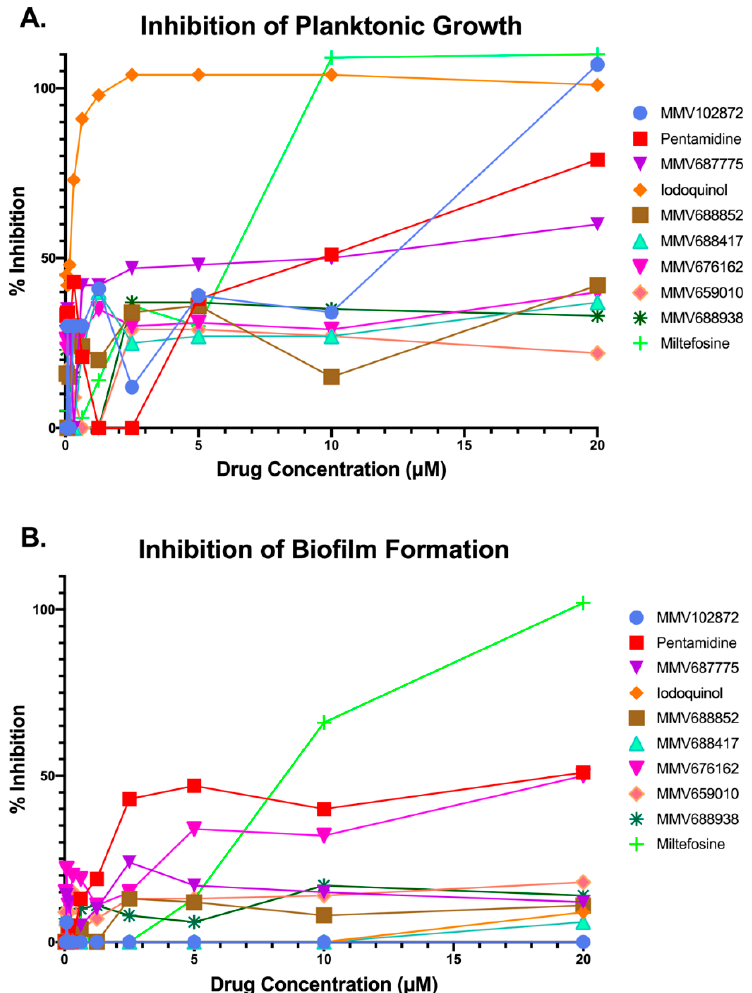
Figure 2. Results from dose-response experiments to confirm the inhibitory activity and determine the potency of initial hit compounds from primary screening against C. auris strain 0390 under planktonic ( A ) and biofilm ( B ) growing conditions.